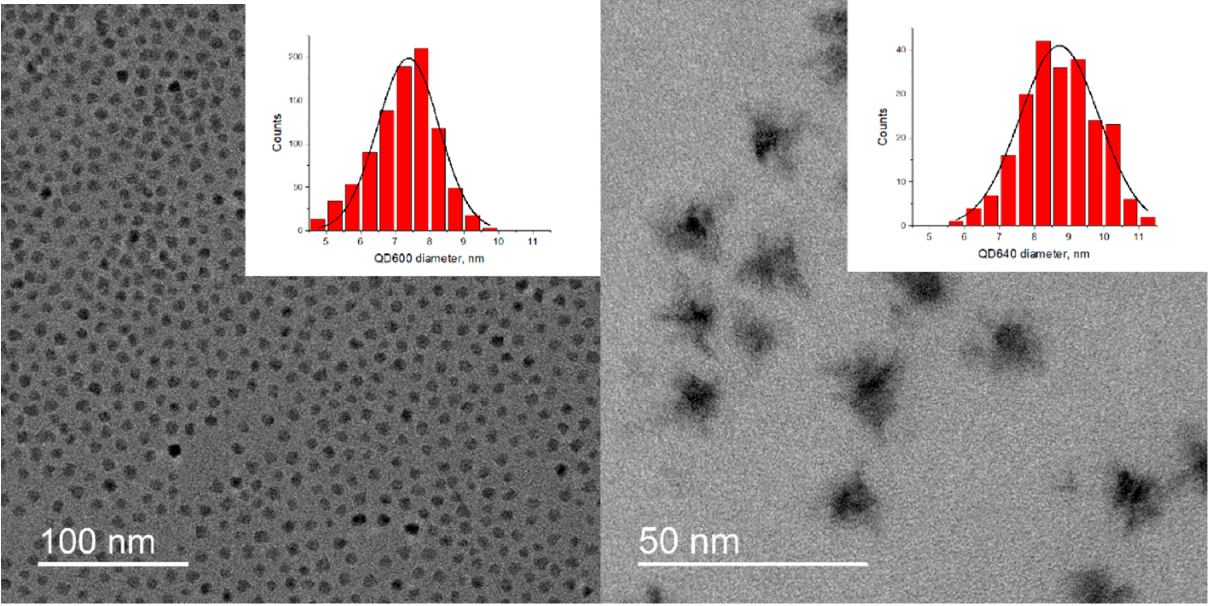
Figure 3. TEM images of QD600 ( left ) and QD640 ( right ) semiconductor cores. Table 1. Structural and spectral properties of QDs. d core is the diameter of the semiconductor